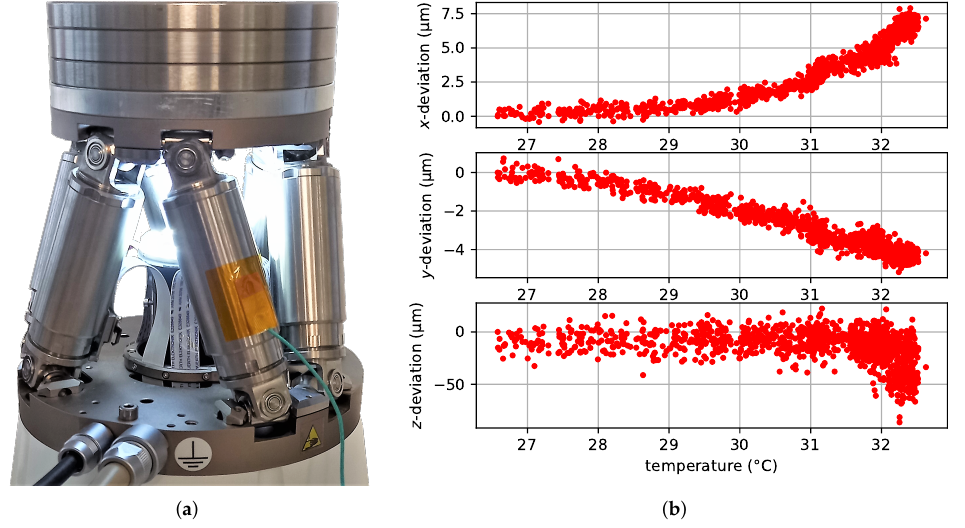
Figure 20. Unwanted motion of the hexapod’s manipulator platform due to temperature deformations of the linear actuators measured with the proposed vision-based pose measurement system and the internal measurement system: ( a ) experimental setup and ( b ) measured deviations in the x -, y -, and z -direction